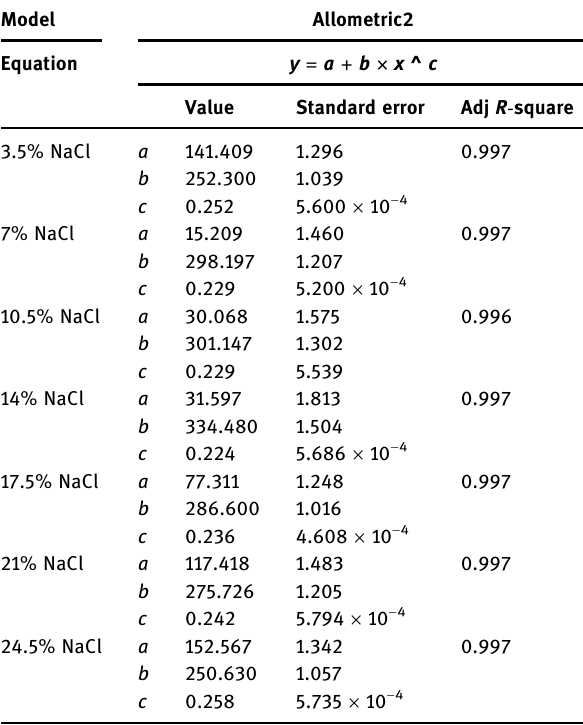
Table 4: Fitting results of plastic zone Model Allometric2